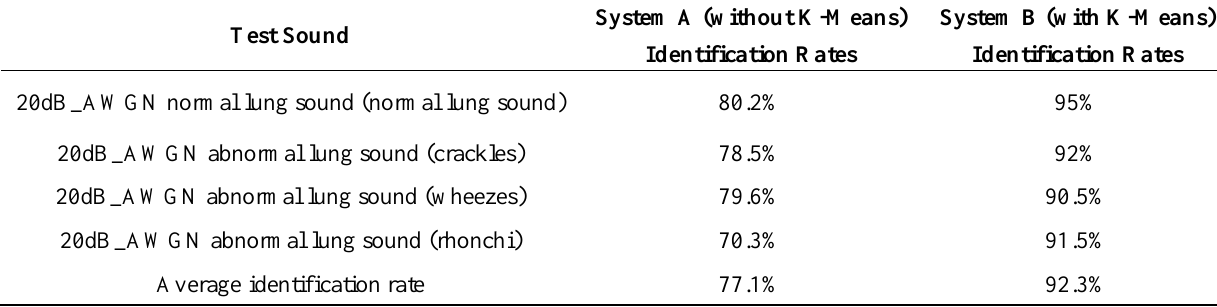
Figure 17. System B: Lung sound identification system with K-means algorithm clustering. Table 3. Identification results of Systems A and B.